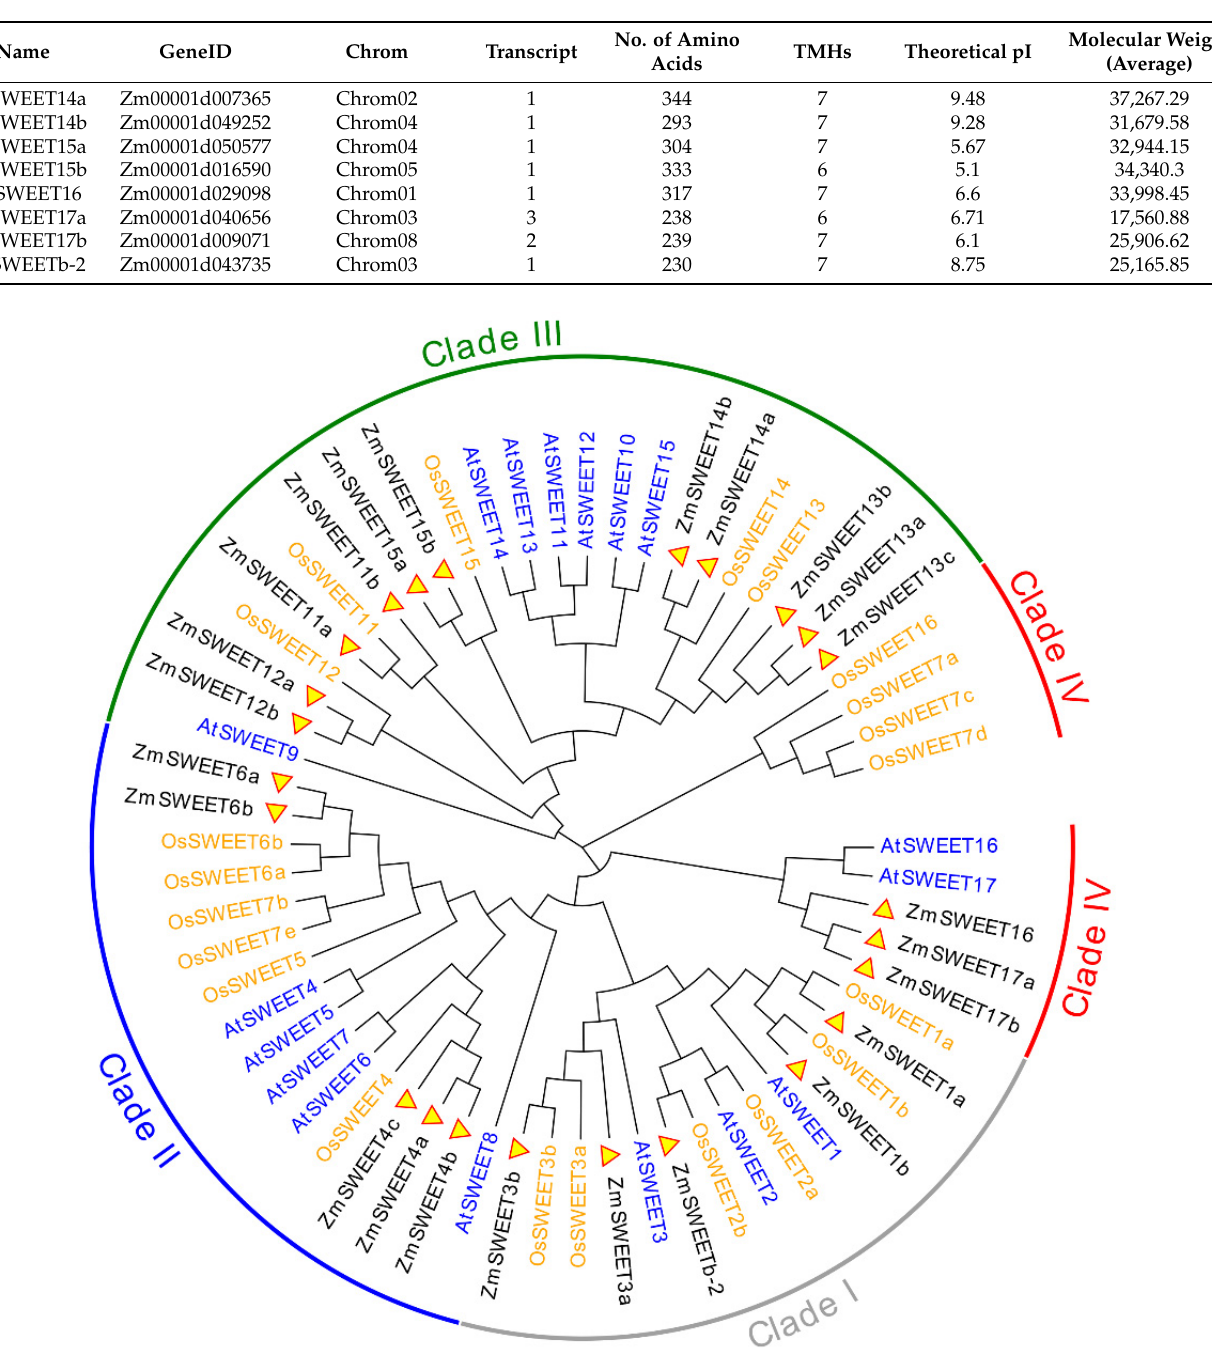
Figure 1. Phylogenetic tree for SWEET proteins of maize, rice, and Arabidopsis. Multiple sequence alignment of the SWEET domains was performed using MUSCLE, and the phylogenetic tree was constructed using MEGA 7.0 with the maximum likelihood method with 1000 bootstrap replicates. The tree was divided into four clades, designated I, II, III, and IV. Proteins of maize, rice, and Arabidopsis are highlighted in black, orange, and blue, respectively.